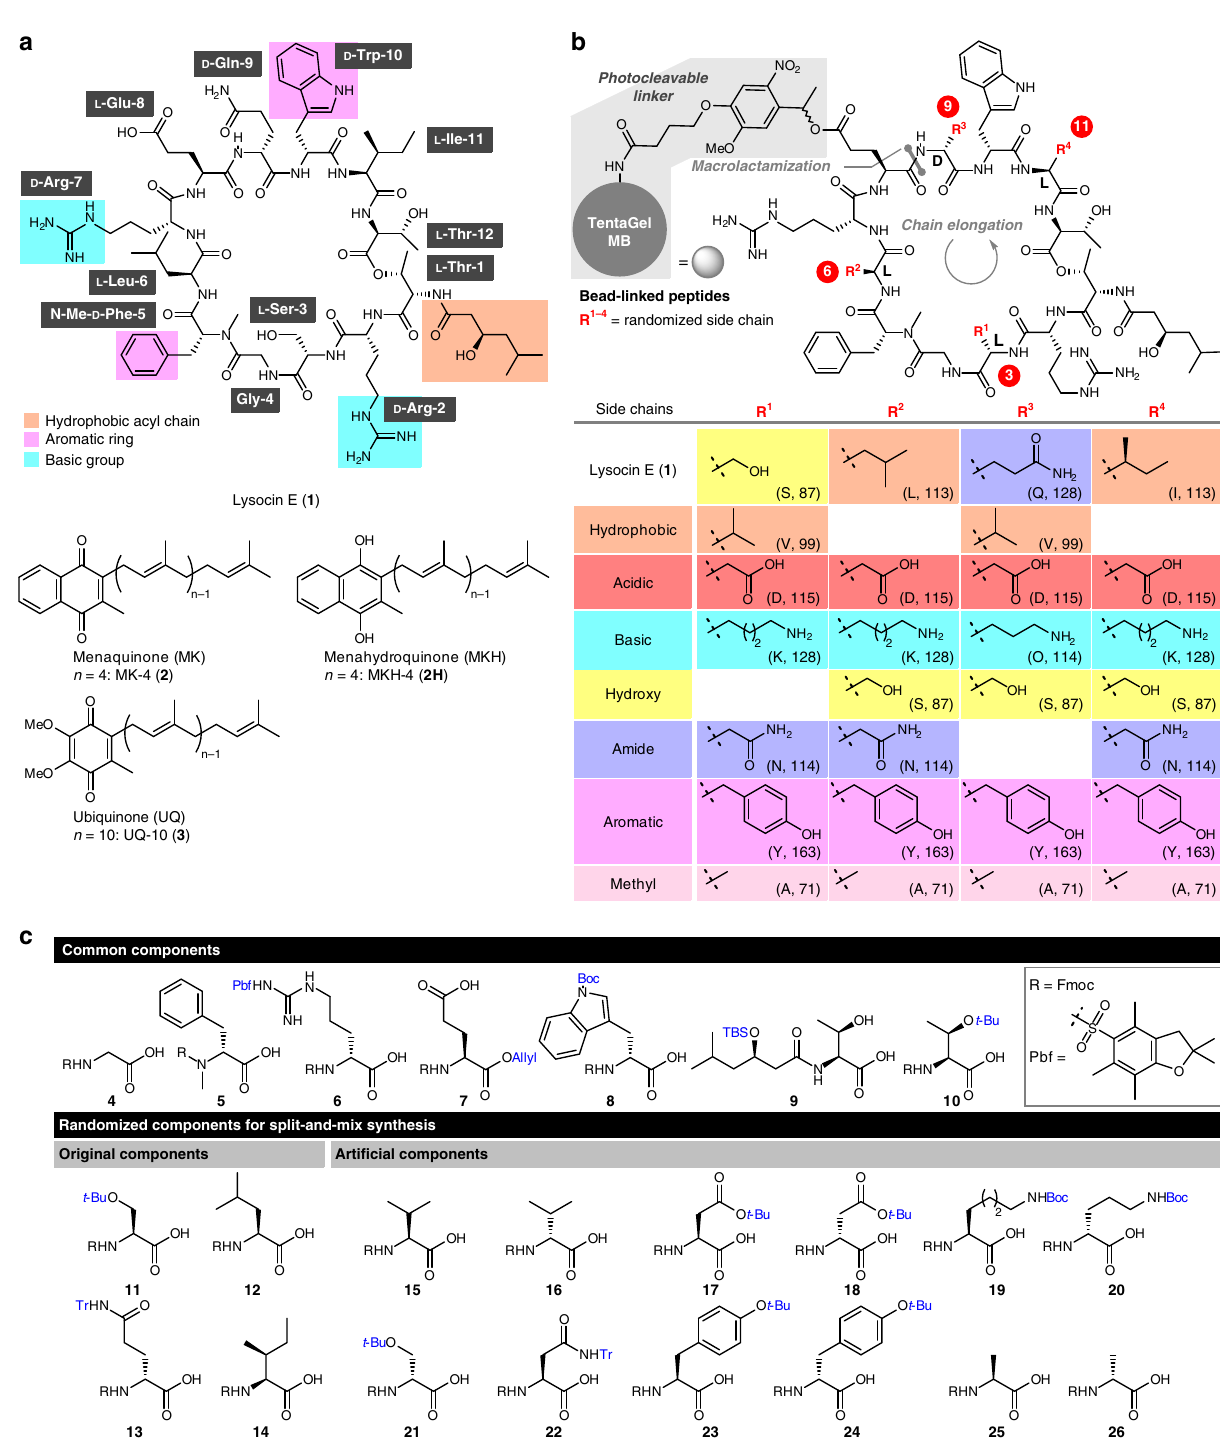
Fig. 1 Chemical structures of compounds used in this study. a Structures of lysocin E ( 1 ), menaquinone-4 (MK-4, 2 ), menahydroquinone-4 (MKH-4, 2 H ), and ubiquinone-10 (UQ-10, 3 ). Side-chain structures of 1 important for the potent antimicrobial activity are highlighted in orange (hydrophobic acyl chain), magenta (aromatic ring), and cyan (basic group). b Structure of the 1 -based one-bead-one-compound (OBOC) library comprising the bead-linked peptides. R 1-4 denote randomized side chains at residues-3, -6, -9, and -11 by split-and-mix synthesis. Table: Structures and properties of side chains at residues-3, -6, -9, and -11 of the bead-linked lysocin E analogues. One-letter codes of the amino acids and molecular weight of the residues are displayed in parentheses. The con fi gurations of residues-3, -6, -9, and -11, sites for the bead-linking and macrolactamization, and direction of the chain elongation are also indicated. Hydrophobic, acidic, basic, hydroxy, primary amide, aromatic, and methyl groups are highlighted in orange, red, cyan, yellow, purple, magenta, and pink, respectively. TentaGel MB TentaGel Macrobeads. c Component amino acids for construction of the 1 -based OBOC library. Protective groups to be removed on a solid support are indicated in blue. Boc t -butoxycarbonyl; Fmoc 9- fl uorenymethoxycarbonyl; Pbf 2,2,4,6,7- pentamethyldihydrobenzofuran-5-sulfonyl; TBS tert -butyldimethylsilyl; t -Bu tert -butyl; Tr